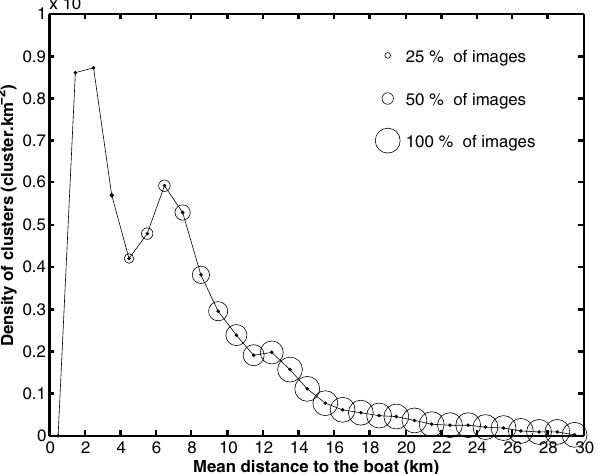
Figure 4. Density of clusters (cluster.km − 2 ) as a function of the distance to the boat (km). Each cluster is located at its mean position. Circles indicate the proportion of images contributing to the estimates; this proportion is lesser at small distances due to numerous images with saturated and unexploited zone in the first kilometres from the